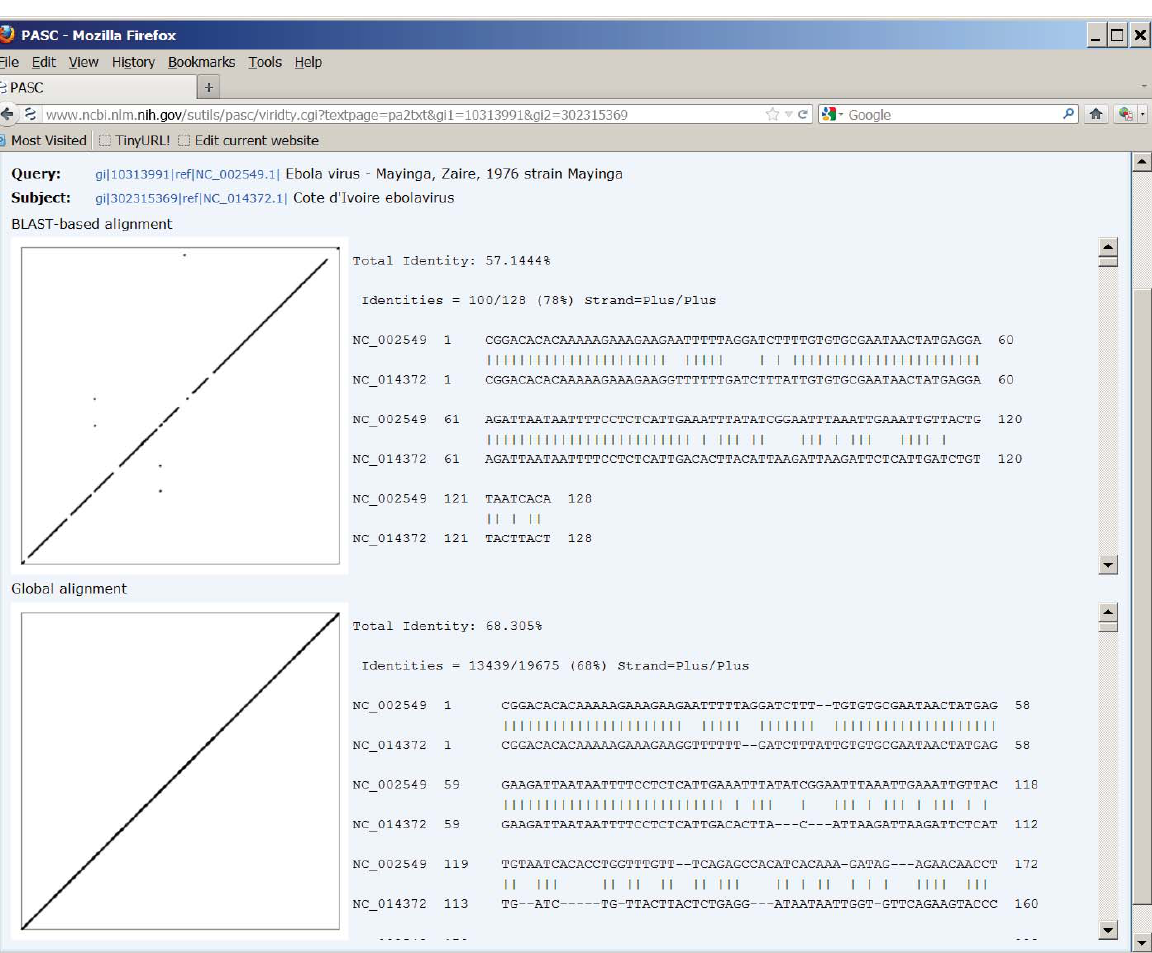
Figure 2. Dot matrix and text views of pairwise alignment between genome sequences of Ebola virus (NC_002549) and Taï Forest virus (NC_014372), using the BLAST-based